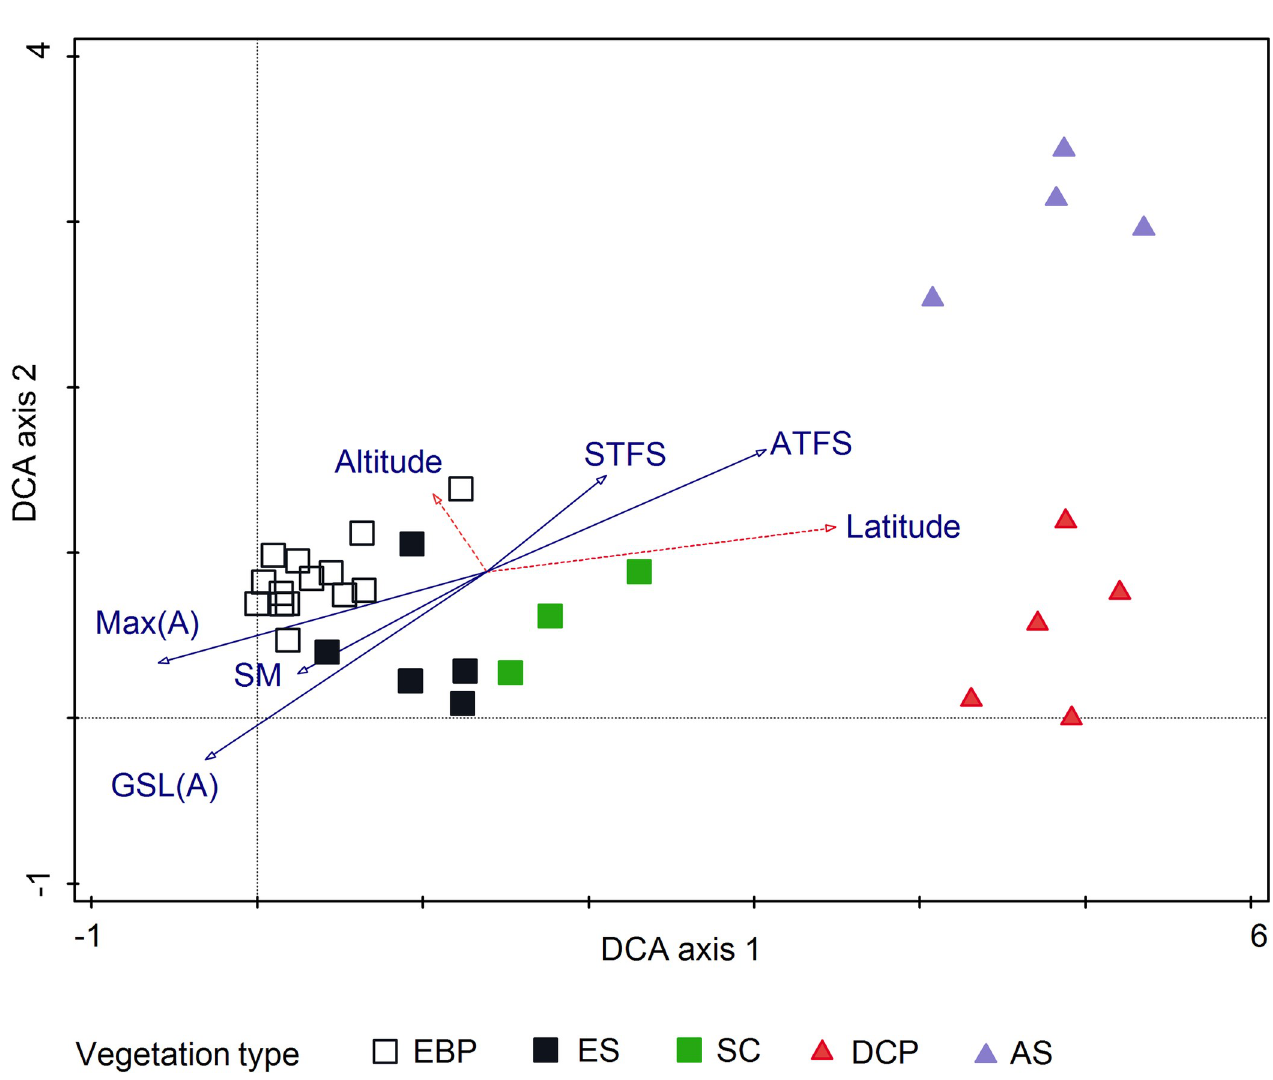
Fig 2. DCA diagram showing clustering of vegetation communities based on TWINSPAN analysis. The main environmental variables (temperature variables and soil properties) obtained from CCA with interactive forward selection, and altitude and latitude have been added as supplementary data. The vegetation types EBP = E . nigrum–B . nana–P . ciliare , ES = E . nigrum–S . herbacea , SC = S . herbacea–C . bigelowii , AS = A . magellanicus–S . uncinata and DCP = D . octopetala–C . tetragona–P . arctica . The total variation was 4.39. Max(A) = Maximum air temperature (˚C), STFS = soil temperature frost sum (dd), GSL(A) = growing season length (based on air temperature) (days), SM = soil moisture (%) and ATFS = air temperature frost